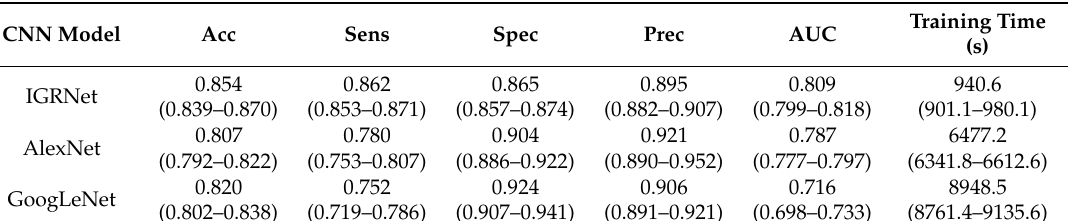
Figure 6. Training and verification processes for IGRNet, AlexNet, and GoogLeNet: ( A ) is the training result of IGRNet, ( B ) is the training result of AlexNet, and ( C ) is the training result of GoogLeNet. Table 5. The results of comparison with deep CNNs. The values represent the average values of the results and their 95% CIs.